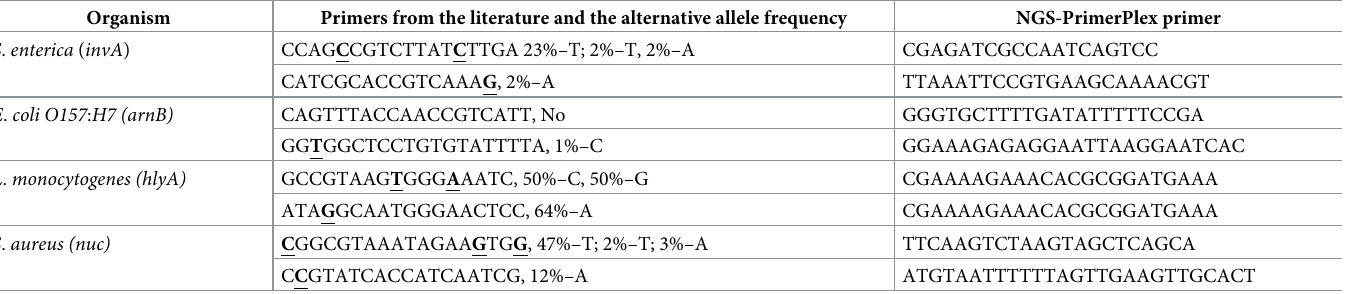
This can be useful for sequencing the most variable parts of genes among different species of one genus or different isolates of one species. Table 1. Primers for the detection of foodborne bacterial pathogens. Variable positions in primers from the literature are in bold and underlined. The second variable position for the first S . enterica primer has two alternative alleles (T and A). Organism Primers from the literature and the alternative allele frequency NGS-PrimerPlex